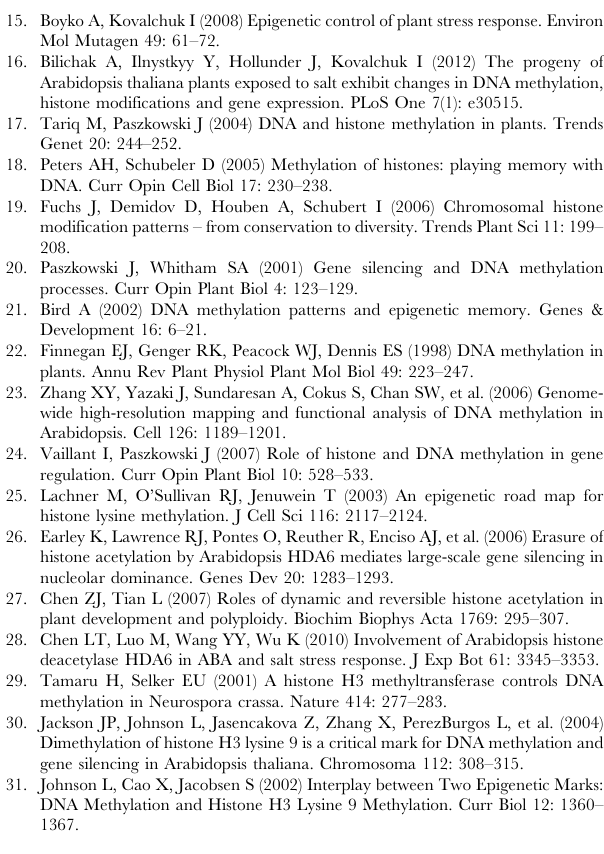
Figure S3 ChIP analysis to assess the unmethylated gene Glyma20g32730 ’s H3K9me2, H3K9ac and H3K4me3 content in plants challenged with salinity. The short bars marked ‘‘a’’ indicate regions subjected to genomic bisulfite sequencing ( + 1 to + 393); ‘‘I, II and III’’ indicate the regions subjected to ChIP analysis. Table S1 The set of TFs identified by microarray analysis to be inducible by salinity stress. Table S2 Sequences of primers employed in this research. Table S3 Correlation analysis among methylation lev- els, gene expression and histone modifications of the four TFs during salinity stress. NC: no